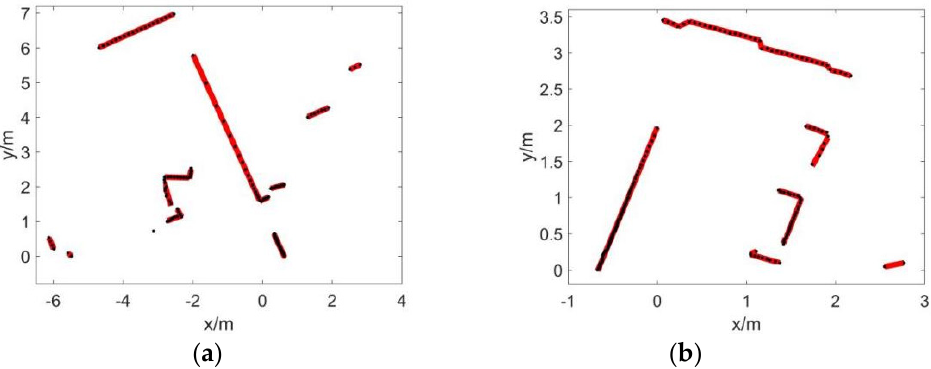
Figure 7. Simulation results of open-source datasets in Intel Research Laboratory: ( a ) multi break- point environment; ( b ) multi-angle environment. environment; ( b ) multi-angle environment.